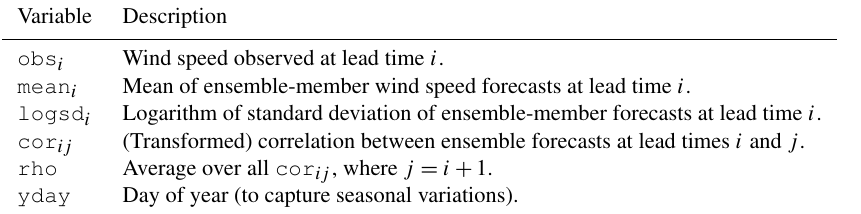
Table 1. Observations and predictor variables used to model distributional parameters for wind speed. The placeholders i and j each stand for 1 of 24 lead times ( + 24, + 25,..., + 47h). Variable Description obs i Wind speed observed at lead time i . mean i Mean of ensemble-member wind speed forecasts at lead time i . logsd i Logarithm of standard deviation of ensemble-member forecasts at lead time i . cor ij (Transformed) correlation between ensemble forecasts at lead times i and j . rho Average over all cor ij , where j = i + 1. yday Day of year (to capture seasonal